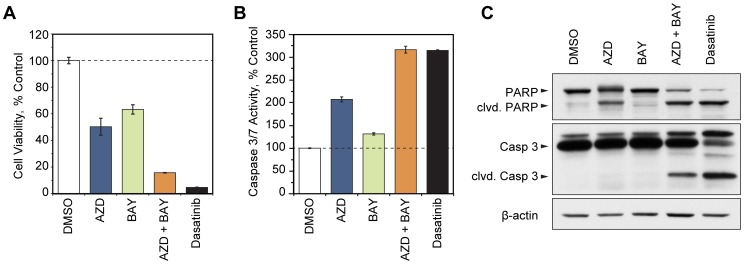
Targeted inhibition of kinases detected by MIB/MS leads to induction of apoptosis.(A) MYL-R cells were treated for 48 hours with AZD6244 (AZD, 5 µM), BAY 65-1942 (BAY, 10 µM), AZD (5 µM) plus BAY (10 µM), or dasatinib (1 nM) and cell viability was assessed by MTS assay. Error bars, SE (N = 3). (B) MYL-R cells were treated for 24 hours with AZD (5 µM), BAY (10 µM), AZD (5 µM) plus BAY (10 µM), or dasatinib (1 nM) and caspase 3/7 activity was assessed by fluorometric assay. Error bars, SE (N = 2). (C) MYL-R cells were treated for 48 hours with AZD (5 µM), BAY (10 µM), AZD (5 µM) plus BAY (10 µM), or dasatinib (1 nM) and cell lysates were analyzed by immunoblot using the antibodies indicated. Data are representative of two separate experiments.